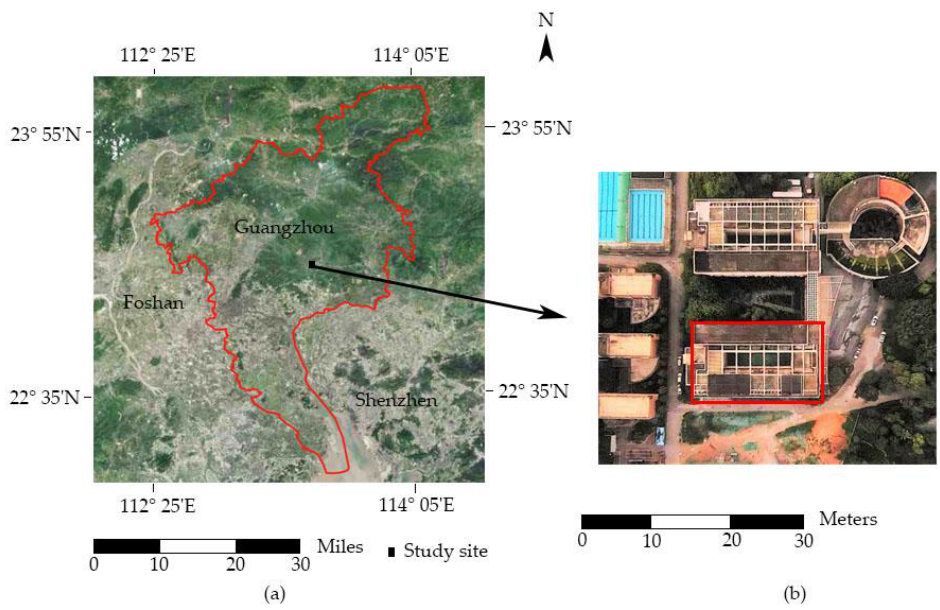
Figure 1. ( a ) Location of the experimental site; ( b ) RGB image of the study area. Table 1. Descriptions of group based on treatment.